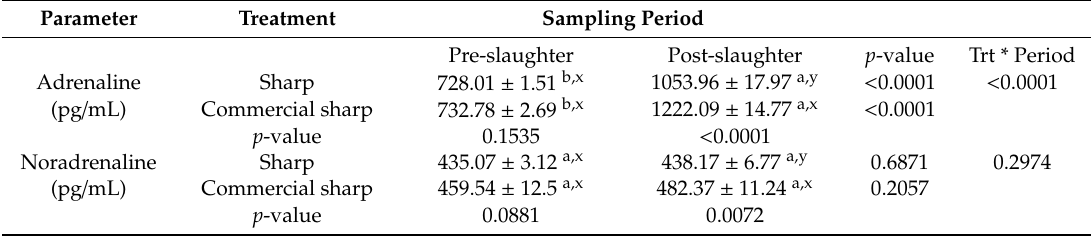
Table 3. Changes in catecholamine parameters in cattle subjected to di ff erent knife